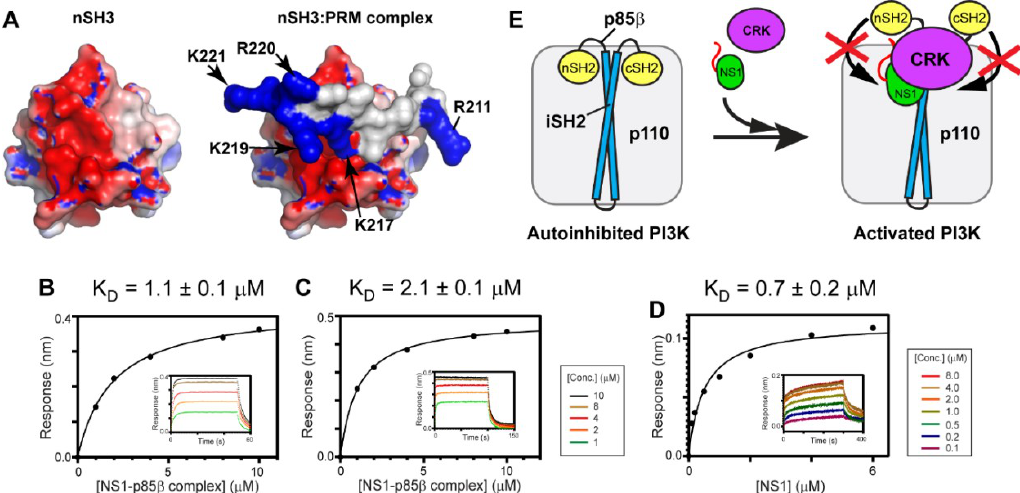
Figure 6. Fuzzy electrostatic interaction between CRK and the 1918 NS1:p85 β complex. ( A ) Crystal structure of the free nSH3 (left) of CRK-II and its complex (right) with PRM of 1918 NS1 (PDB ID: 5UL6). The protein surface is colored according to electric potential at neutral pH from -5 kT (red) to + 5 kT (blue). (right panel) Positively charged residues of PRM are shown in blue. BLI-derived binding isotherms between the 1918 NS1 ED-CTT :p85 β iSH2 complex and ( B ) CRK-II and ( C ) CRK-L in the presence of 1M NaCl. ( D ) BLI-derived binding isotherm between 1918 NS1 ED-CTT and p85 β iSH2 in the presence of 1M NaCl. Insets: representative BLI sensorgrams with di ff erent analyte concentrations are shown by di ff erent colors. ( E ) A schematic model showing how 1918 NS1 might enhance activation of PI3K using hijacked CRK.